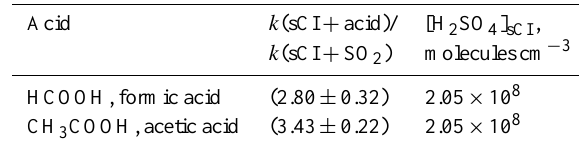
Table 3. Relative reaction rate coefficients for reaction of (CH 3 ) 2 COO (sCI from TME ozonolysis) with small organic acids and SO 2 based on competitive reaction kinetics